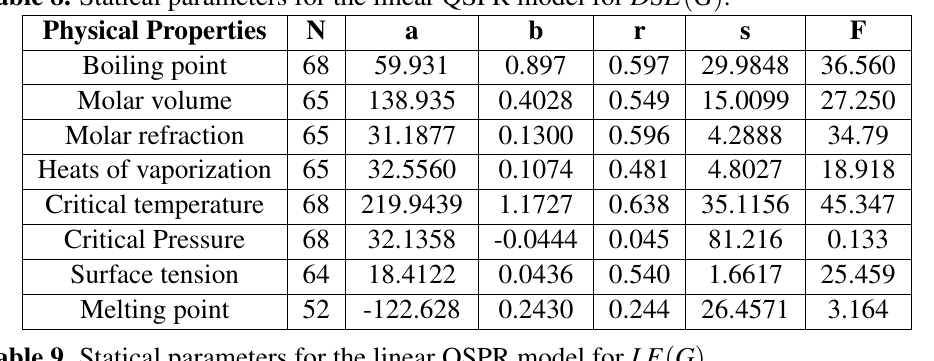
Table 9. Statical parameters for the linear QSPR model for LE ( G ) .